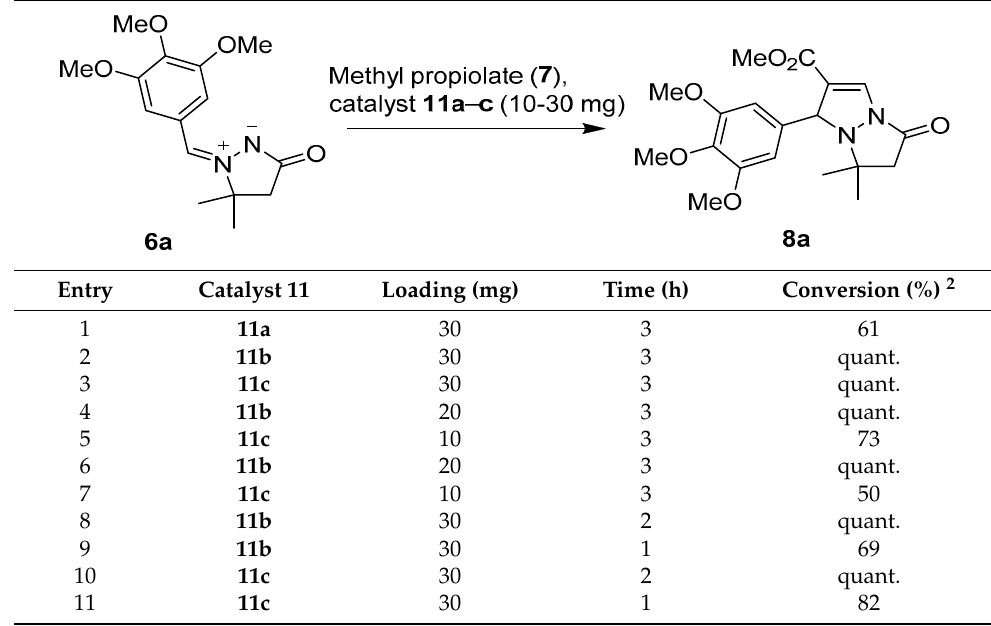
Table 3. Catalytic activity of heterogeneous Cu(II) catalysts 11a – c in model reaction 1 .